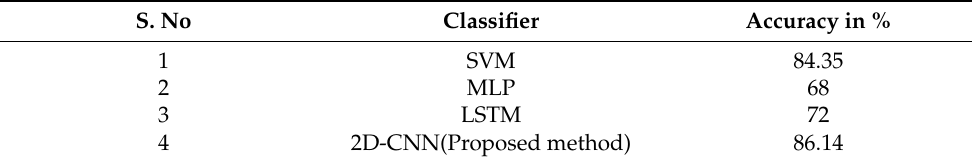
Table 5. Comparison with different state-of-the-art